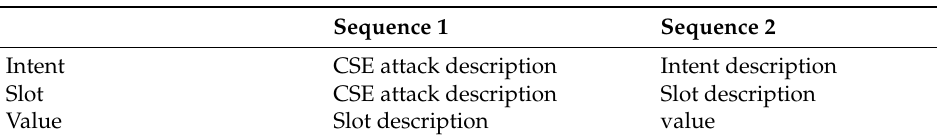
Table 7. Sequence pair used for embeddings.